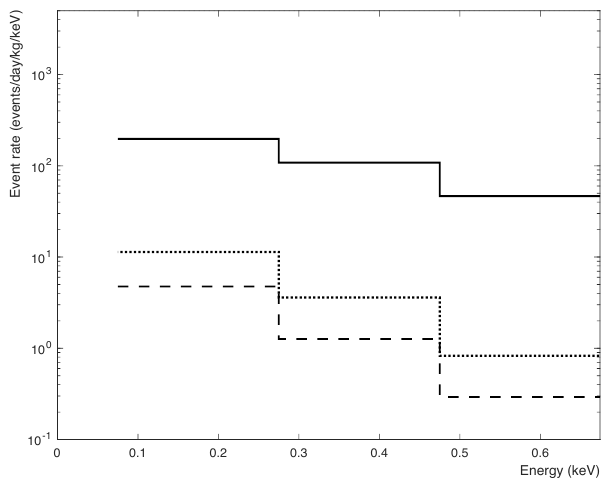
Figure 1 . 95% con(cid:12)dence level limits from RON-ROFF measurements (solid line) and CE (cid:23) NS expected event rate using measurements in ref. [33] (dashed line) and expressions in ref. [34] (dotted line) for the quenching factor. Figure from ref.